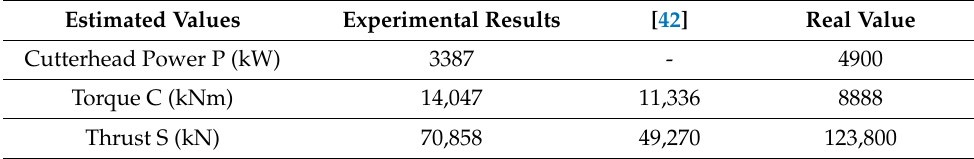
Table 5. Correlation equations, obtained for single shield TBMs, between the power supplied to the excavation head (P), the torque (C) and the thrust (S) as a function of the diameter. Model Developed in the Present Study [42] P = 94,279D 1.4792 - C = 110.42D 2.0014 C = 90,478D 1.9951 S = 1364.3D 1.6314 S = 2261.5D 1.2726 Table 6. P, C, S values estimated with the experimental models and real values. Estimated Values Experimental Results [42] Real Value Cutterhead Power P (kW) 3387 -